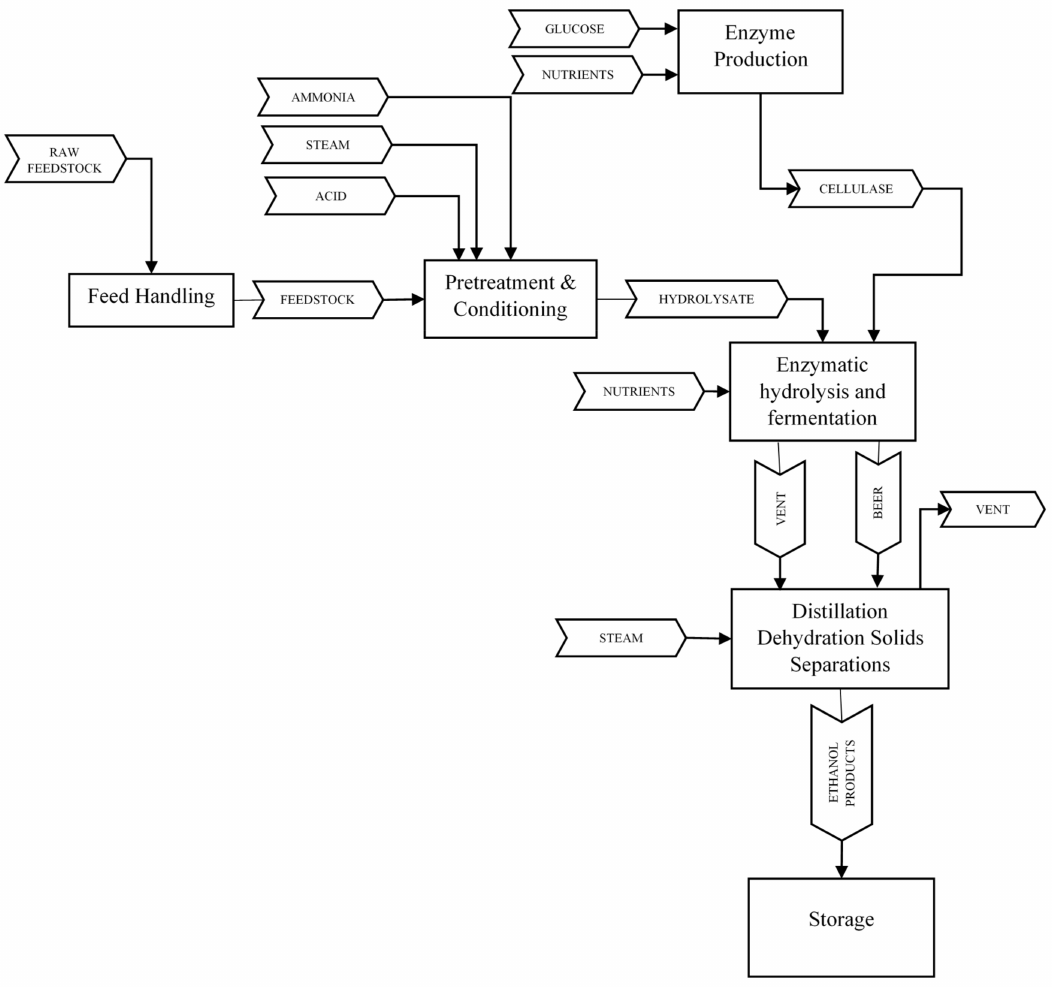
Figure 1. Process of a biofuel refinery adapted from